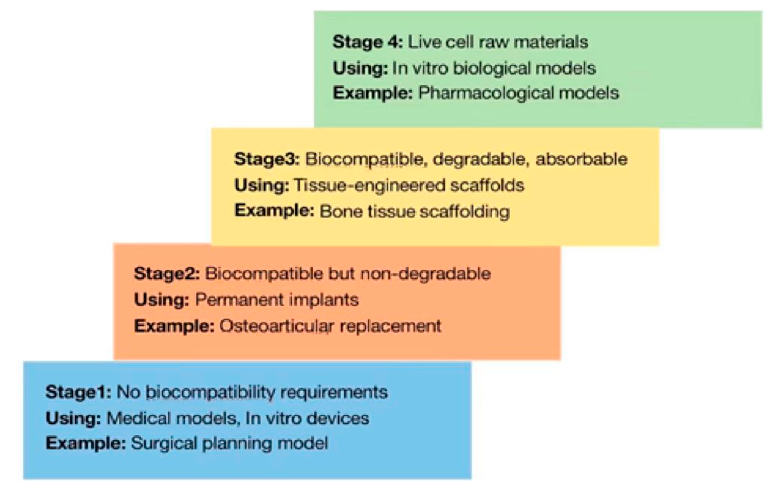
Figure 1. Different stages of development of 3D printing [2].